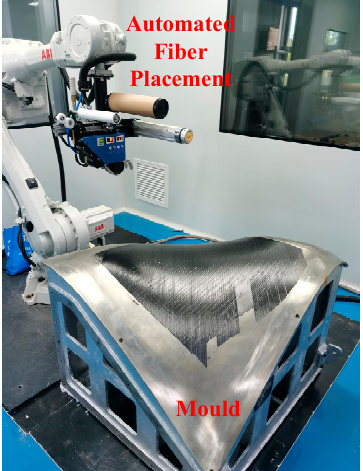
Figure 13. Automated fiber placement experimental platform.